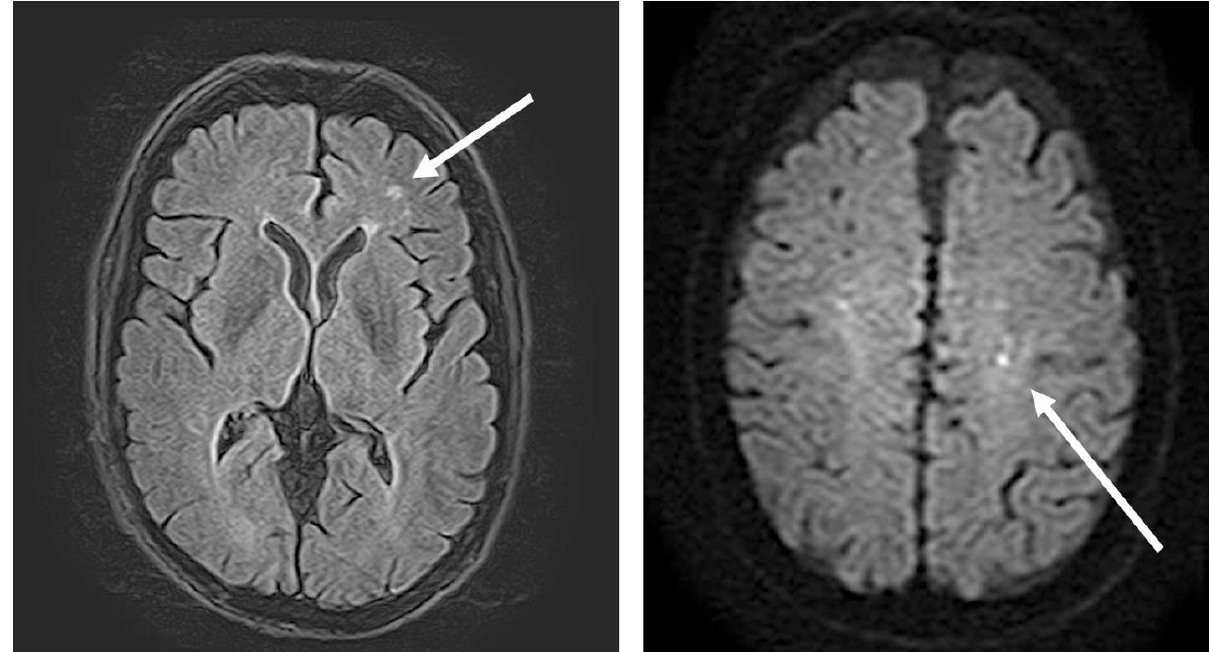
Figure 2. MRI of the brain with contrast. ( Left ): Scattered nonspecific supratentorial white matter FLAIR hyperintensities, suggesting chronic small vessel disease. ( Right ): Subcentimeter focus restricted diffusion left centrum semiovale extending to the subcortical white matter of the left precentral gyrus, concerning a recent small vessel infarct. No hemorrhage was present.